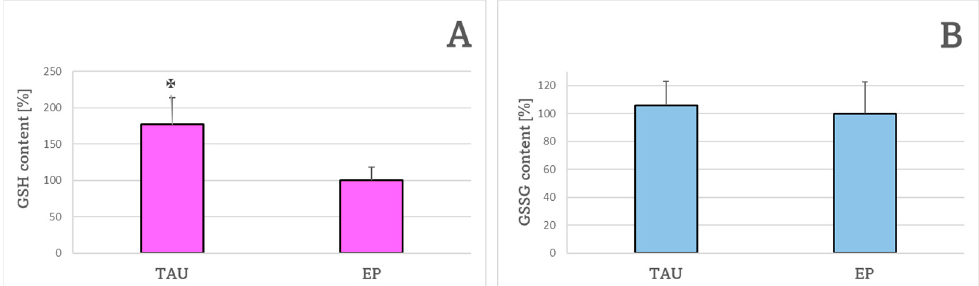
Figure 4. The content of reduced glutathione ( A ) and oxidized glutathione ( B ) in TAU and EP SH-SY5Y cells after 24 h. GSH and GSSG content in EP cells assumed as 100%. (cid:122) p < 0.05 (TAU vs. EP); n = 3. The level of lipid peroxidation estimated with the BODIPY C11 probe was considerably lower in TAU cells compared to EP cells (Figure 5).